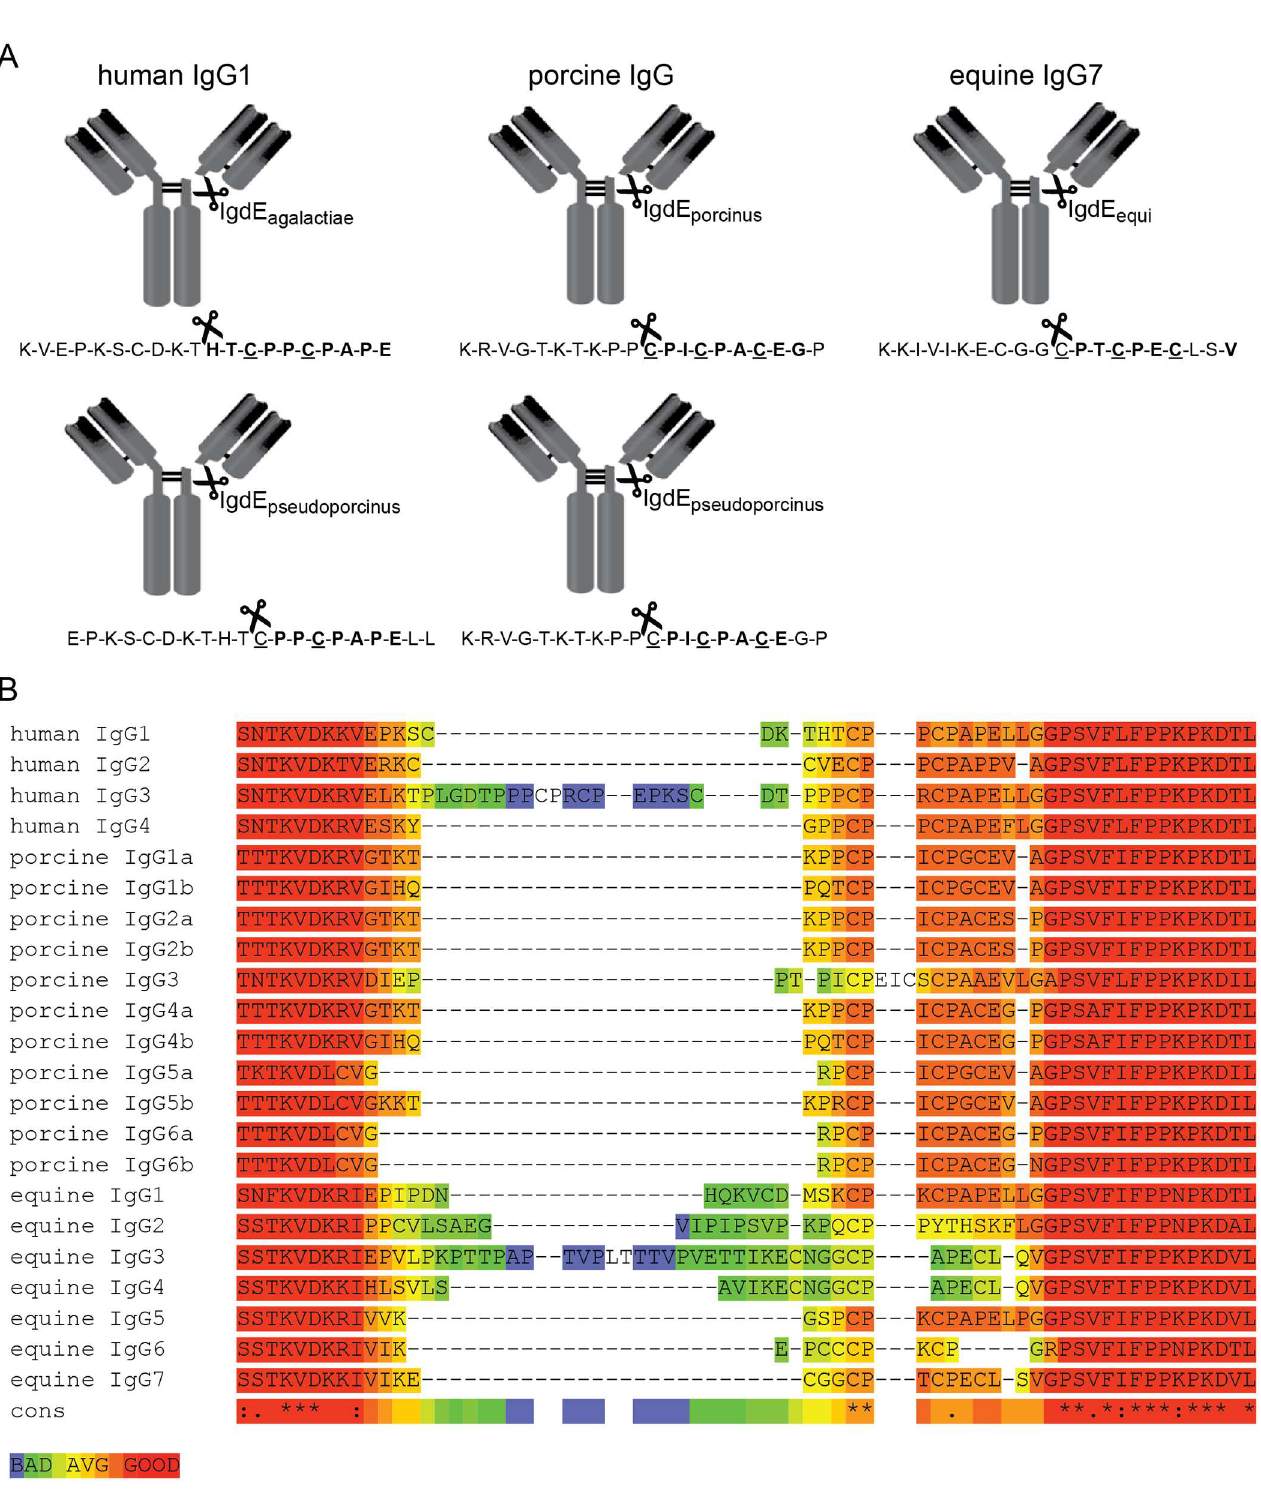
Fig 6. IgdE family proteases cleave IgG in the hinge region. (A) The cleavagesites within IgG molecules were determinedthrough N-terminal Edman sequencing of the 32 kDa IgG cleavageproducts generated by IgdE family proteases. The identifiedaa sequences ( bold ) were found in the hinge regions of the respective IgG heavy chains. Homodimer disulfidebond cysteine residues are underlined. 10 aa N- and C-terminal from the identifiedcleavagesite (scissor symbol) of the respective IgG heavy chain are shown. Porcine IgG4a was chosen as a representative for porcine IgG. (B) Sequences of the hinge regions and adjacent parts of the CH1 and CH2 domains of human, porcineand equineIgG